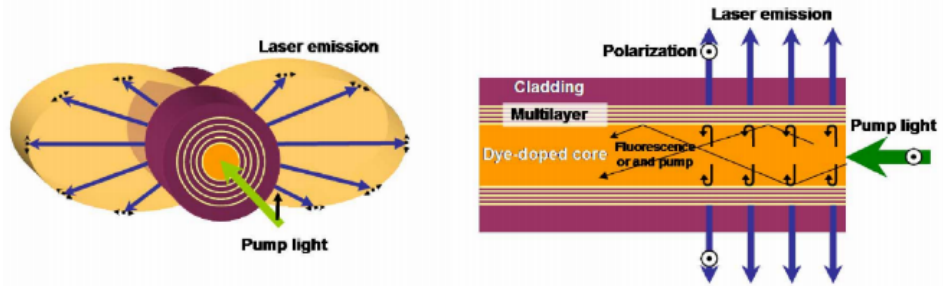
Figure 3. Schematic diagram of microcavity laser based on hollow core Bragg fiber, with dye-doped core, axial pump light, and transverse emitting [42].